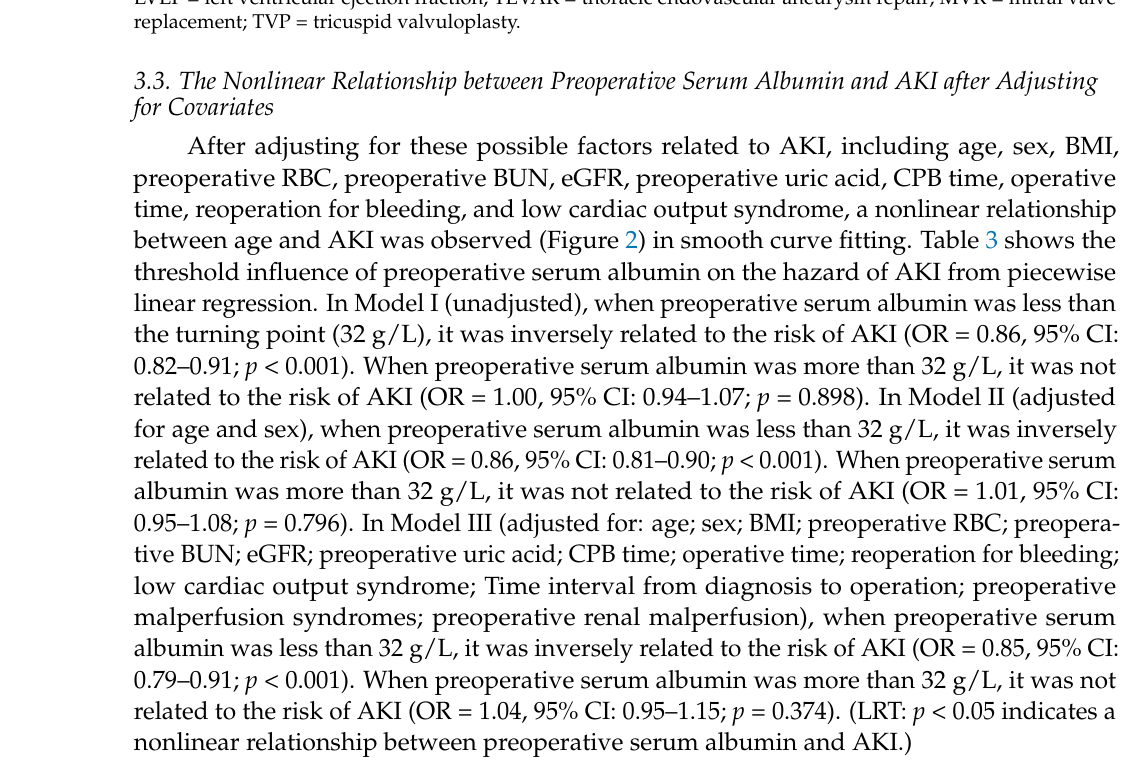
Table 3. Threshold effect of preoperative albumin on postoperative AKI in patients with acute type A aortic